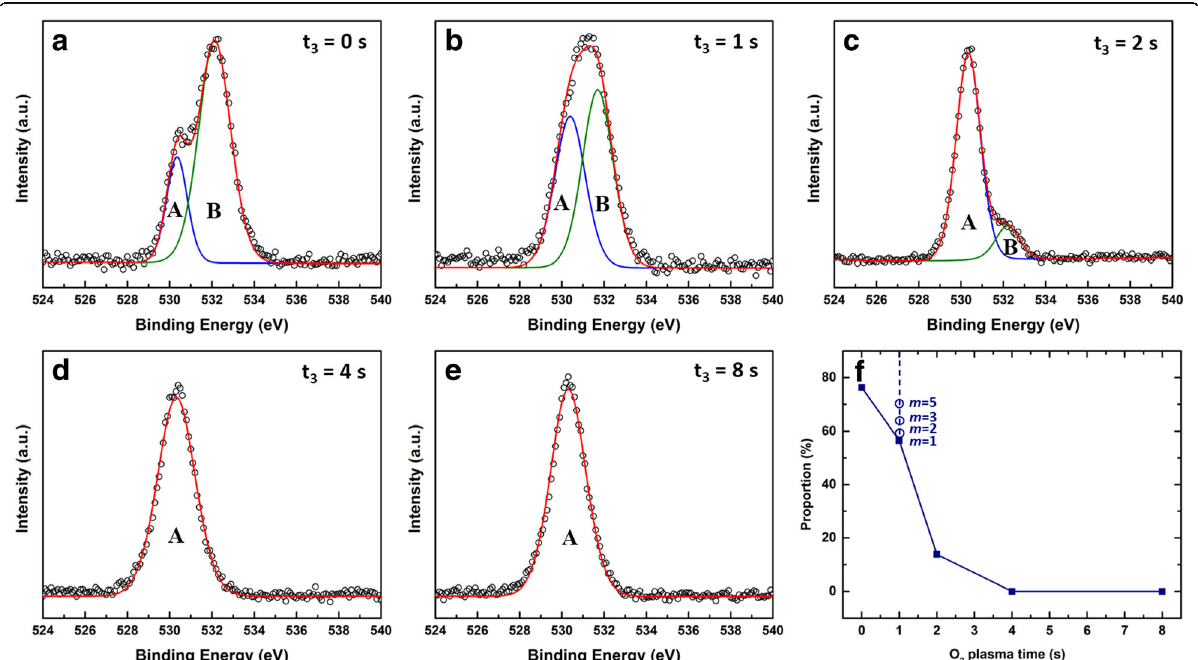
Fig. 6 a – e XPS spectra and their Gaussian fittings of the O 1 s region of the supercycled ALD-grown ZnO films with O 2 plasma time ( t 3 ) varying from 0 to 8 s and fixed thermal cycle ( m = 1). f Proportion of the hydrogen-related O B peak in ZnO films grown with varying O 2 plasma times (solid dots) and thermal cycles (open